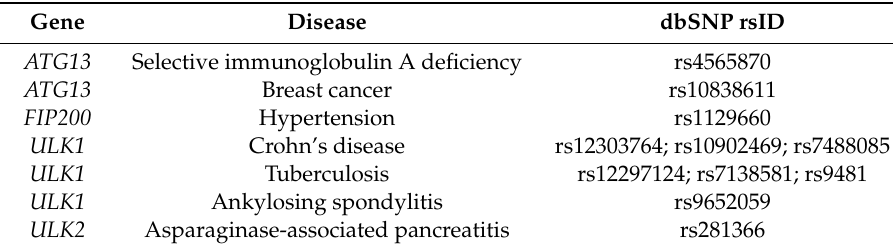
Table 1. Clinically relevant SNPs in ULK1/2 complex.